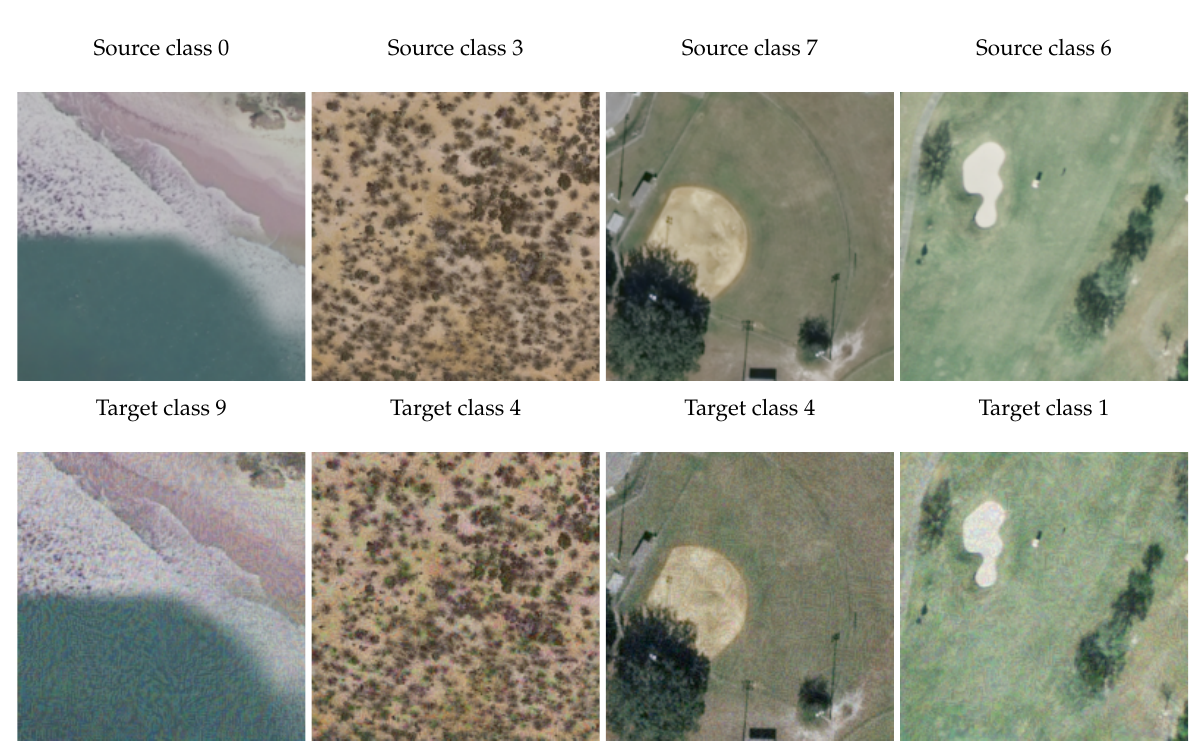
Figure 5. Samples of Source-Targeted Universal Adversarial Examples on UCM. The upper row shows the images from source classes, while the lower row shows the corresponding targeted adversarial examples, misleading the victim models to predict the target